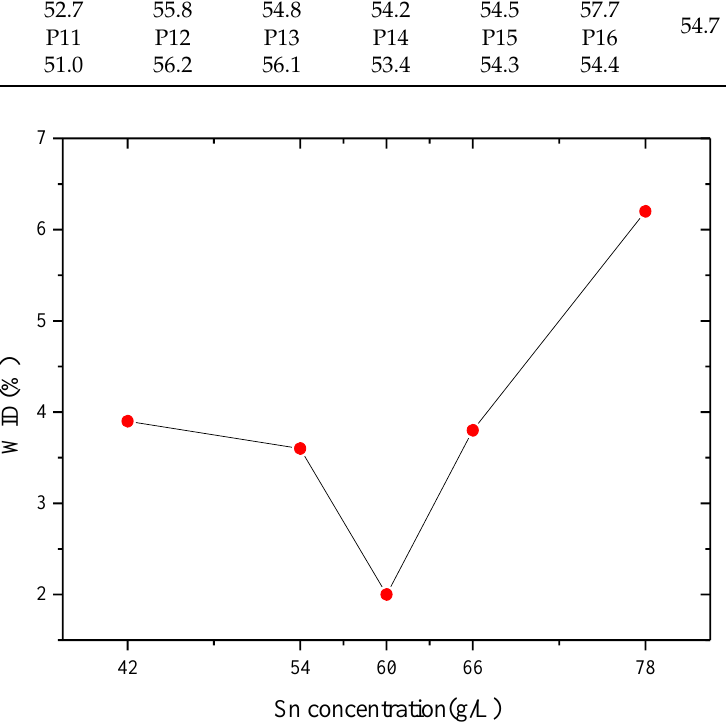
Figure 3. Height deviation of bump when additive is added, WID.